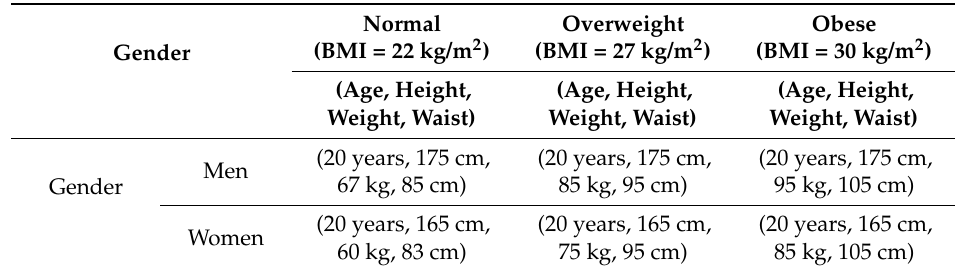
Table 1. Starting value of covariates (age, height, weight, waist circumference) for the three body